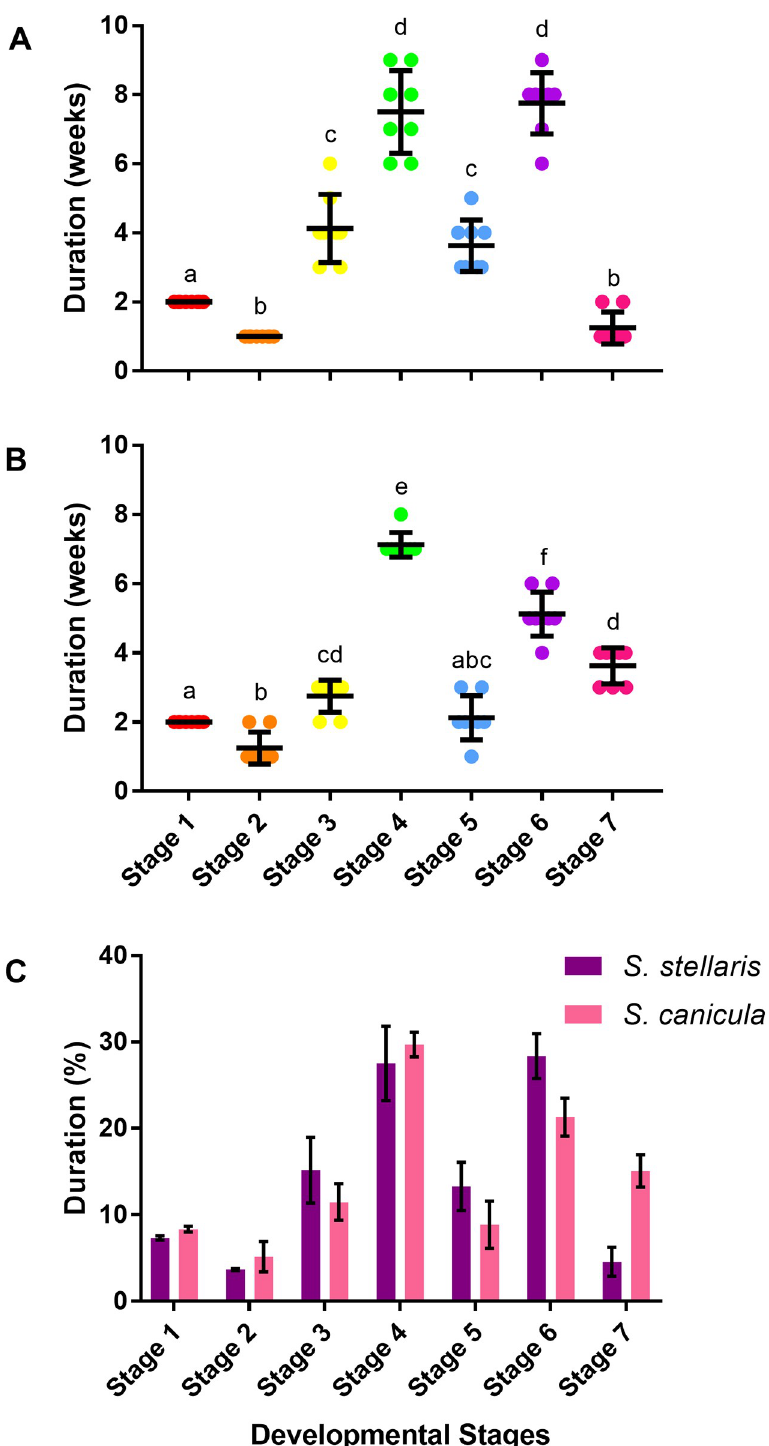
Fig 13. Duration of development time of the 7 developmental stages. A: Duration of development time (in weeks) spent in each of the 7 developmental stages for S . stellaris embryos. Lines show mean ± SD (n = 8), while points show measurements from each individual. Dissimilar letters indicate statistical differences between stages (RM one-way ANOVA, P < 0.05). B: Duration of development time (in weeks) spent in each of the 7 developmental stages for S . canicula embryos. Lines show mean ± SD (n = 8), while points show measurements from each individual. Dissimilar